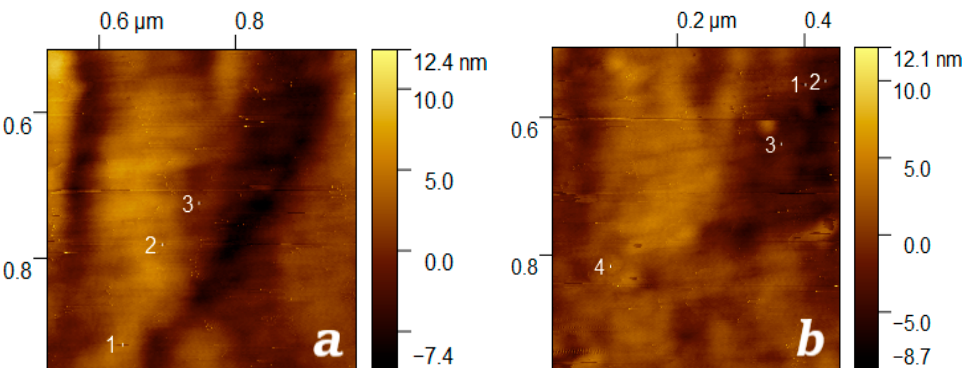
Figure 8. Enlarged fragments of a topographic image of the surface of a thermoradiationally modified polytetrafluoroethylene film (Figure 6b) irradiated with a stream of xenon ions up to 10 8 cm − 2 : 1–3 ( a ), 1–4 ( b )—tracks of xenon ions are indicated by white line segments.